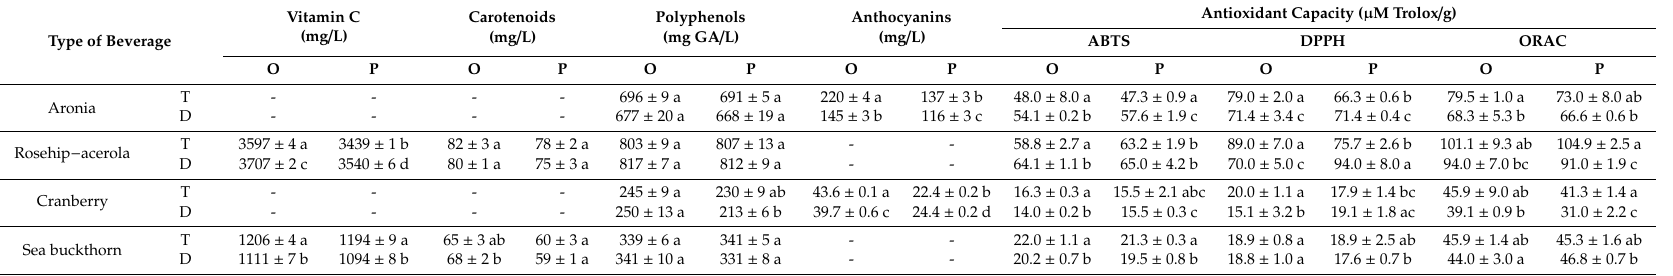
Table 2. Physicochemical characteristic of fruit-herbal functional